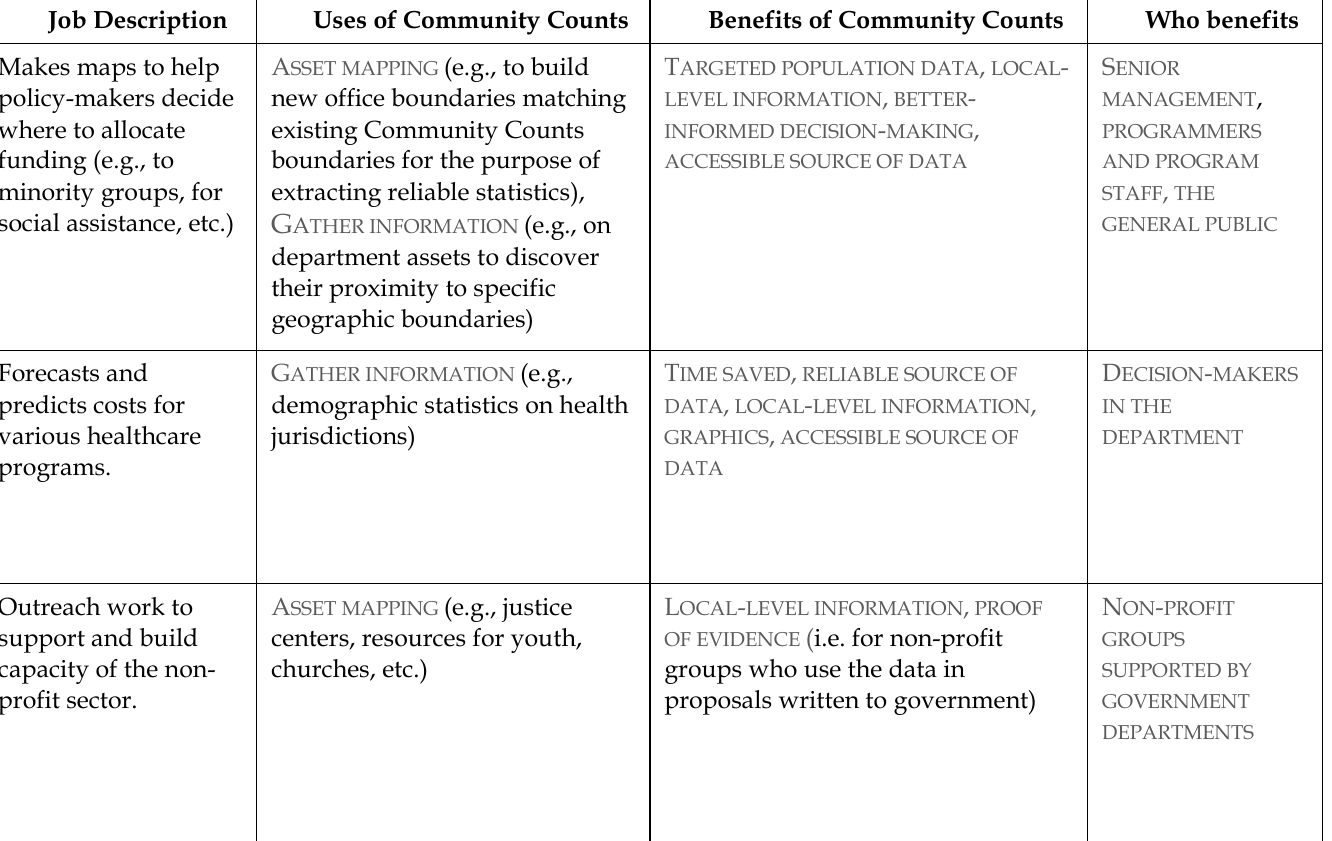
Table 4: Community Counts Sector Study Summaries from Key Informant Interviews